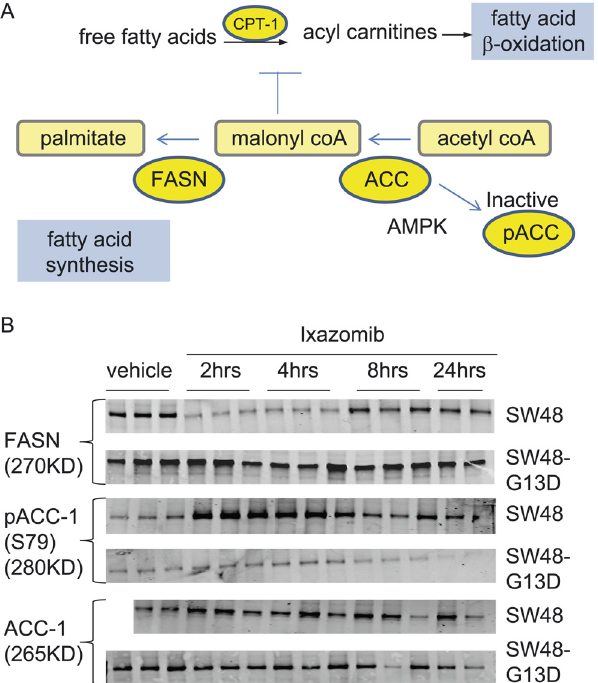
Fig 7. Ixazomib effect on key enzymes of lipid metabolism. (A) Enzymes and metabolites in lipid synthesis and β -oxidation pathways. (B) Regulation of FASN, pACC-1(S79) and ACC-1 proteins following vehicle and ixazomib treatment. The vehicle samples were collected at 4hrs after dosing and the ixazomib treated samples were collected at different time points (as indicated in the figure) after the drug treatment. (Note: For SW48 ACC1 blot there were two samples in vehicle group and thus there were only 14 samples for that